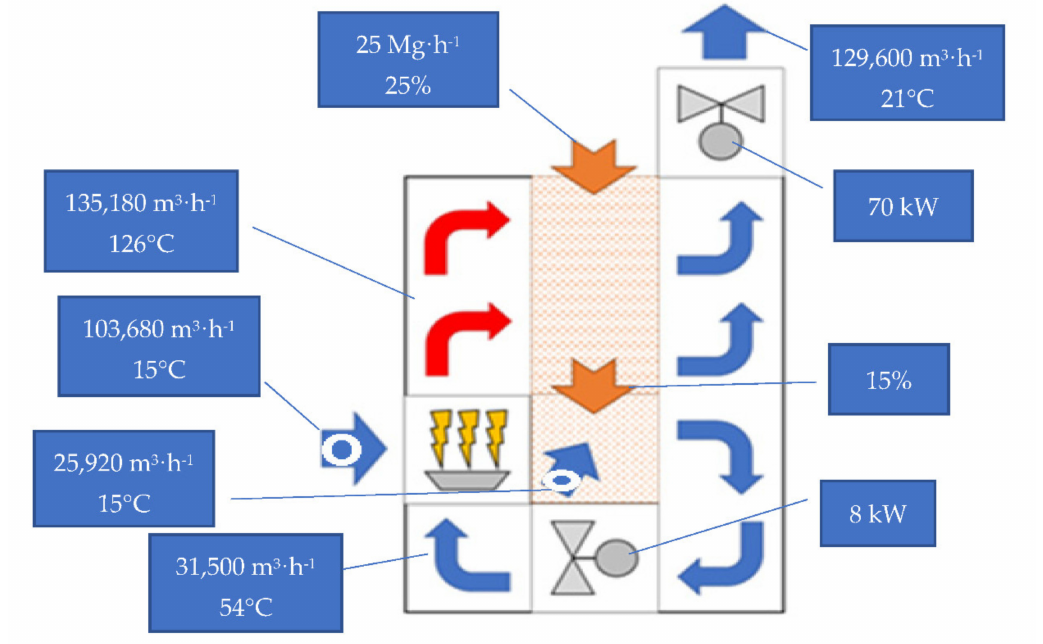
Figure 7. Graphic representation of the test results of the S428.CS